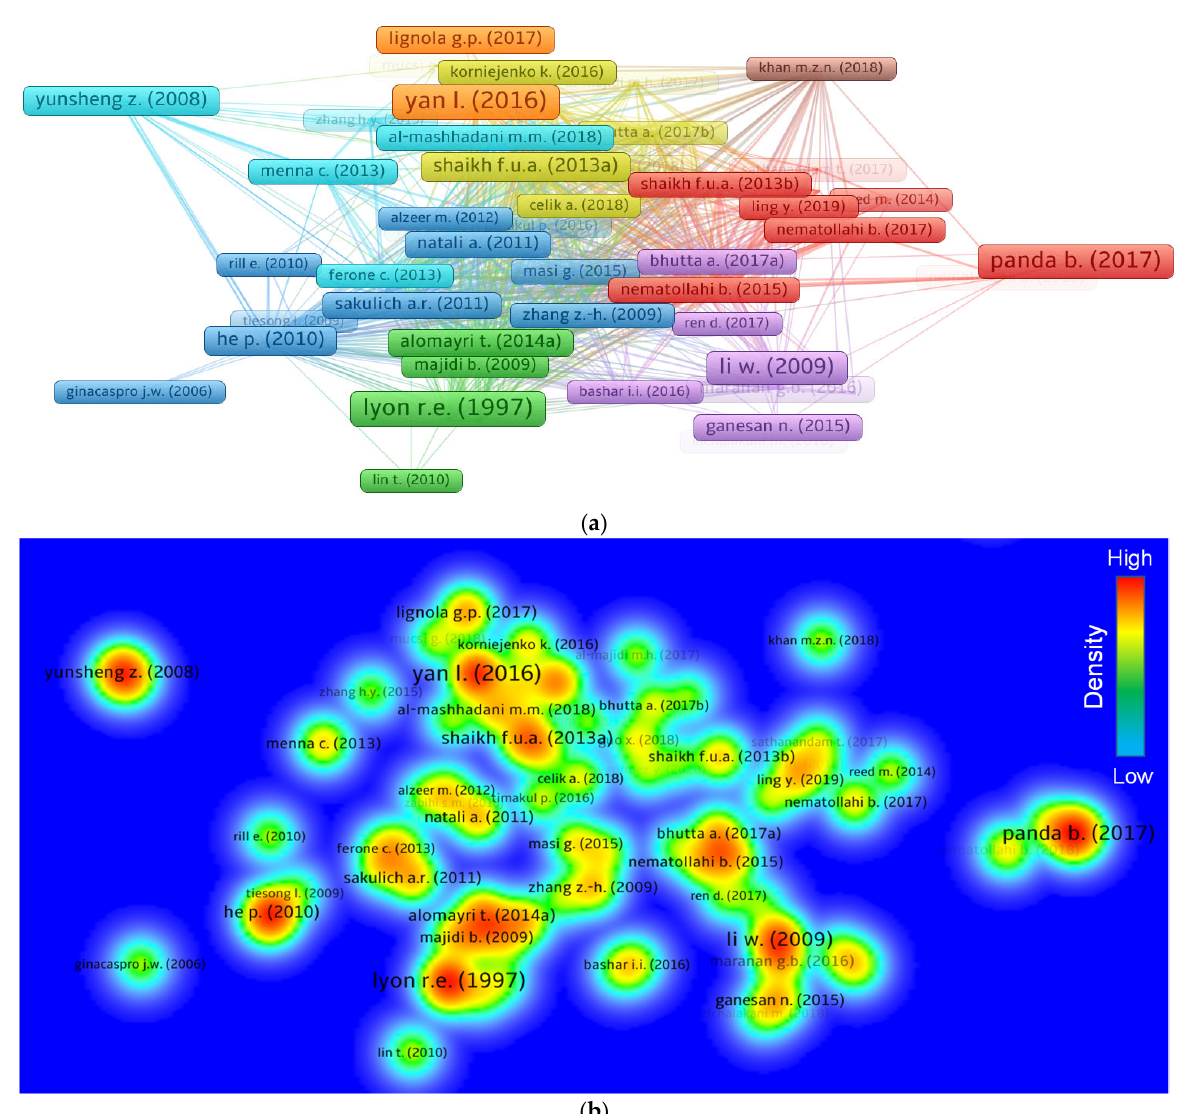
Figure 8. Systematic mapping of papers: ( a ) connected articles based on citations; ( b ) density of connected